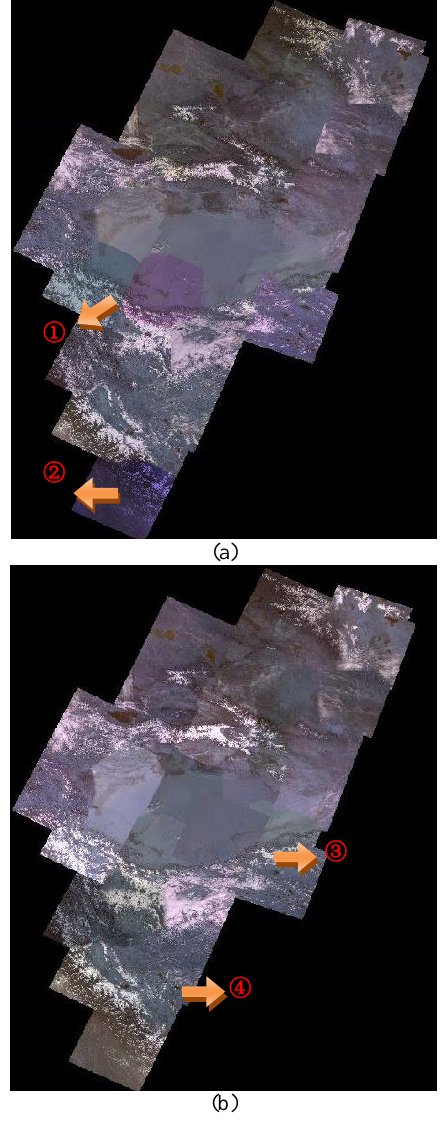
Figure 12. The experimental result (a) Traditional method; (b) Edge-center